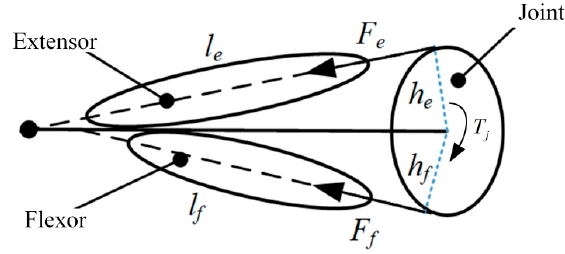
Figure 5. Muscle control model of a single joint.